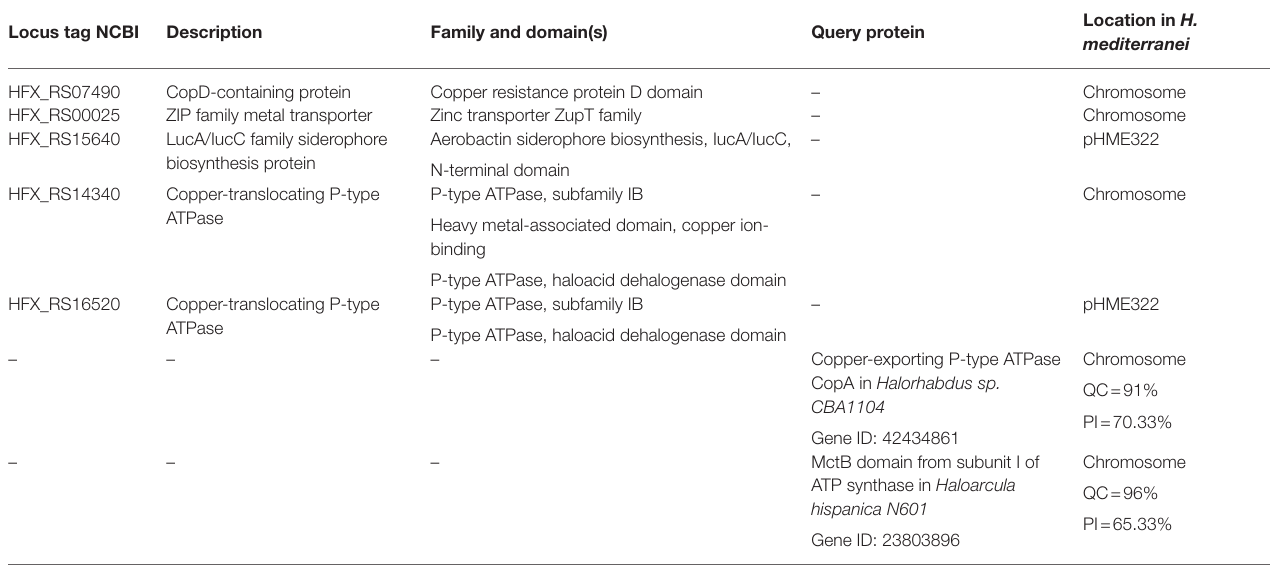
TABLE 1 | Genes encoding copper membrane transporters found in Haloferax mediterranei. Locus tag